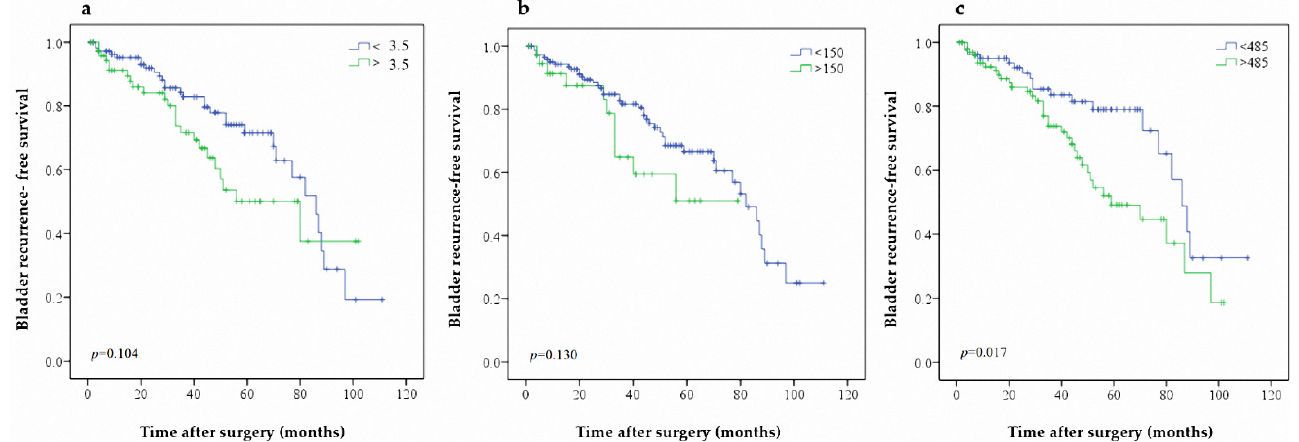
Figure 3. Predictive value of ( a ) NLR ( b ) PLR and ( c ) SII on BRFS in patients with UTUC after RNU. Additionally, 108 patients (28.7%) had bladder recurrence during follow-up (female, 52 patients; male, 56 patients). The 3- and 5-year BRFS rates were 78.6% and 63.5%, respectively. Univariate analysis showed that male gender ( p = 0.001), bladder cancer history ( p = 0.001), pT4 pathological stage ( p = 0.011), high tumor grade ( p = 0.020), adjuvant chemotherapy ( p < 0.001), and elevated SII ( p = 0.026) were associated with worse BRFS (Table